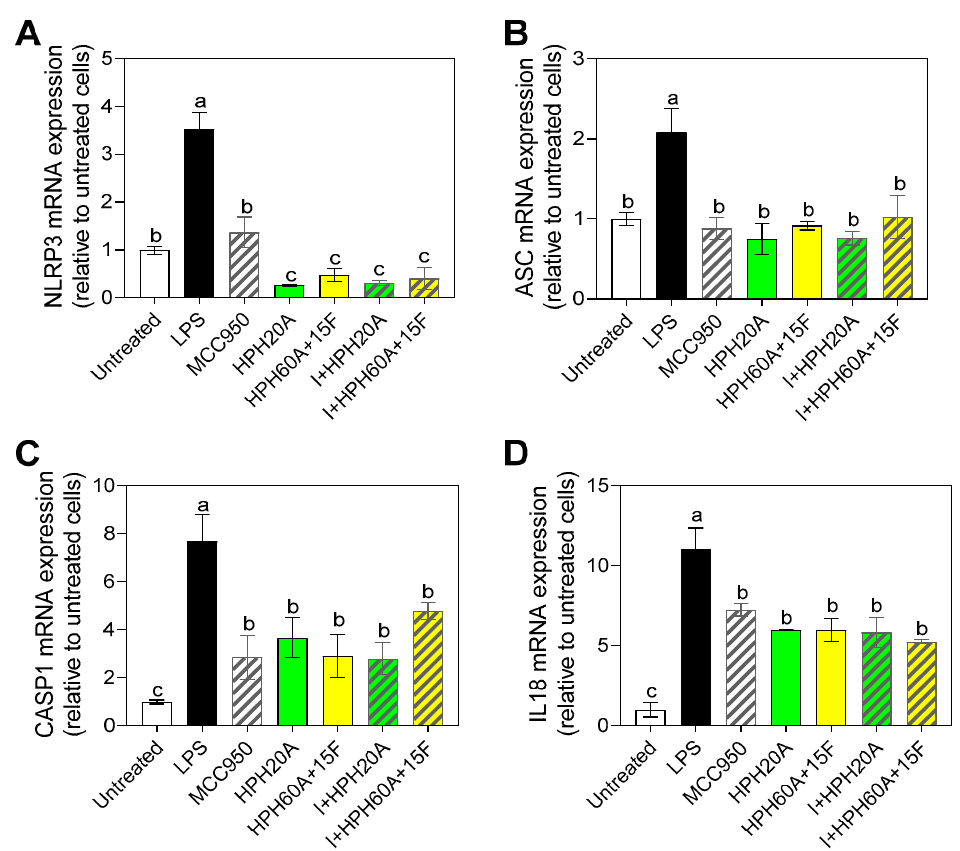
Figure 6. Nlrp3 ( A ), Asc ( B ), Casp1 ( C ), and Il18 ( D ) mRNA gene expression in BV-2 cells after 24 h incubation with or without stimulation with LPS (1 µ g/mL), as well as following treatment with MCC950 (I) as a specific inhibitor of the inflammasome and/or HPHs (100 µ g/mL). Values are presented as the means ± SDs ( n = 3); Different letters denote significant differences among the samples. ( p < 0.05).